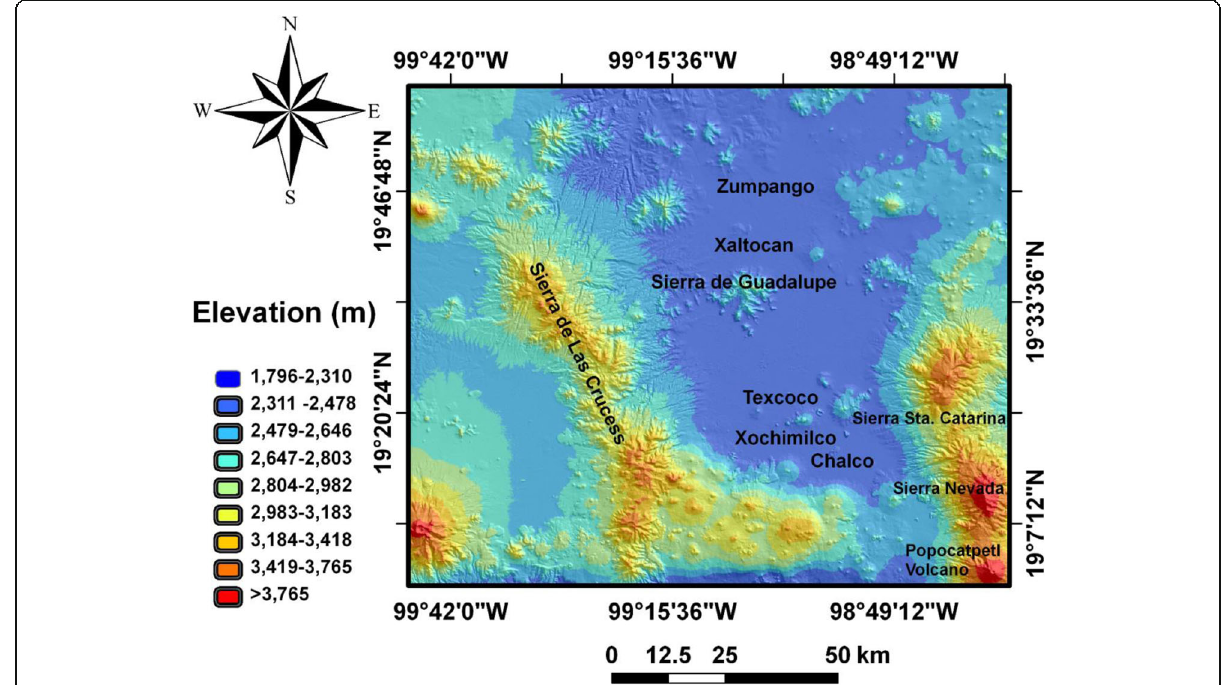
Fig. 2 Shaded relief map of Mexico City overlaid by topography